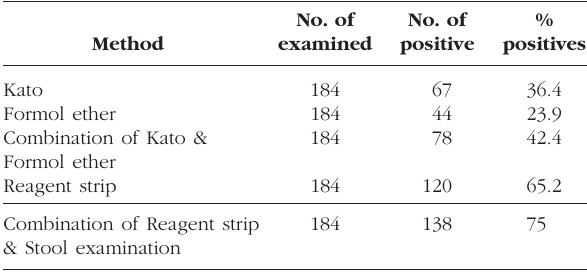
Table I. – Prevalence of schistosomiasis mansoni in Kemmie primary schoolchildren as detected by various methods.